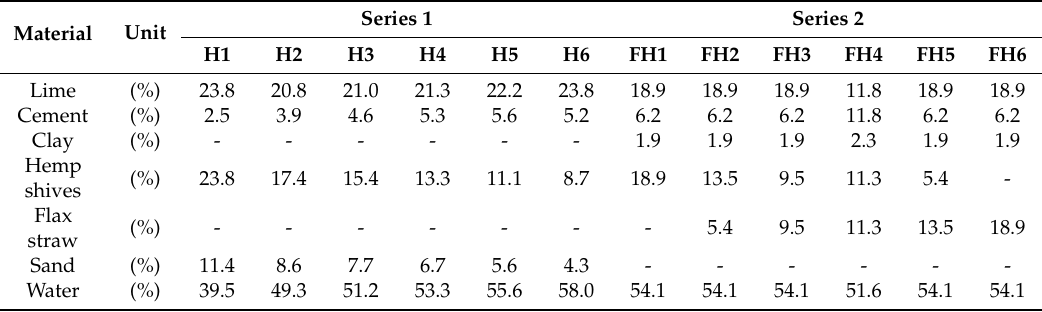
Table 1. Proportions of compounds used for composites preparation (percentage by weight).